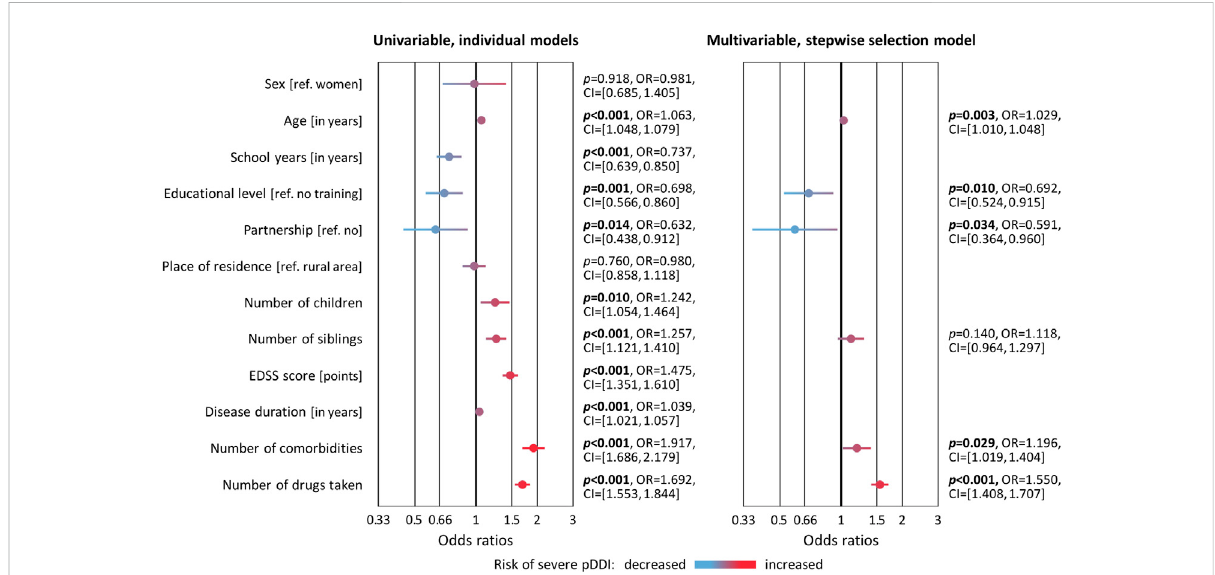
FIGURE 4 Factors associated with the occurrence of severe potential drug-drug interactions in patients with multiple sclerosis. A subset of 221 of the 627patientshadatleastoneseverepDDIaccordingtoatleastoneofthethreedatabasesused.Binarylogisticregressionanalyseswereperformedto test for 12 variables whether they are associated with the risk of having a severe pDDI. This was done using each variable individually (univariable models) and the best predictive subset of variables (stepwise selection model). The ORs and 95% CIs from these models are shown as forest plots. p -values < 0.05 are marked in bold. CI, con fi dence interval; EDSS, Expanded Disability Status Scale; OR, odds ratio; pDDI, potential drug-drug interaction; ref.,